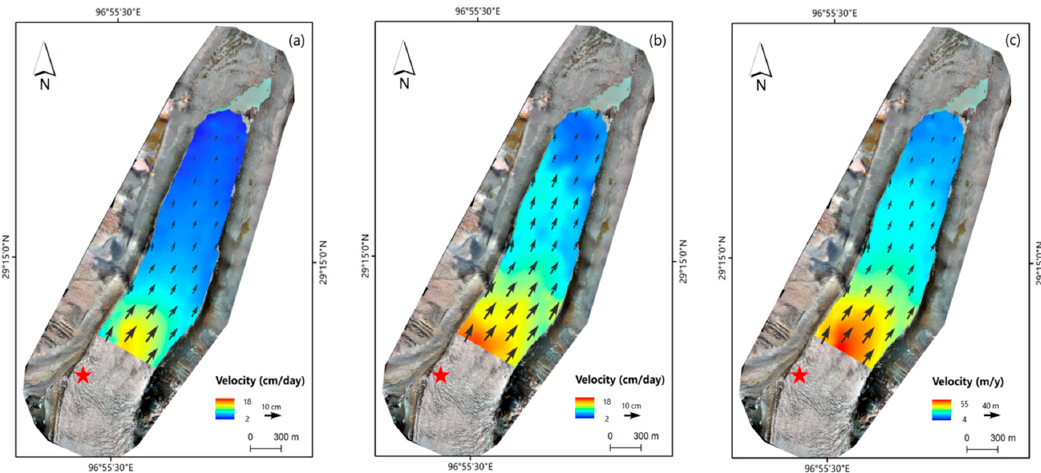
Figure 8. Mean daily flow vector for cold season ( a ), warm season ( b ) and annual total movement ( c ) at the lower part of Parlung No. 4 Glacier, with the location of a cluster of surface debris (red star) to derive the point horizontal displacement near the icefall region.